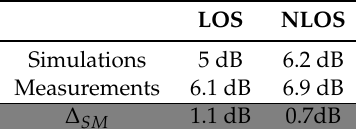
Table 7. Summary of the performance for a target BER of 10 − 4